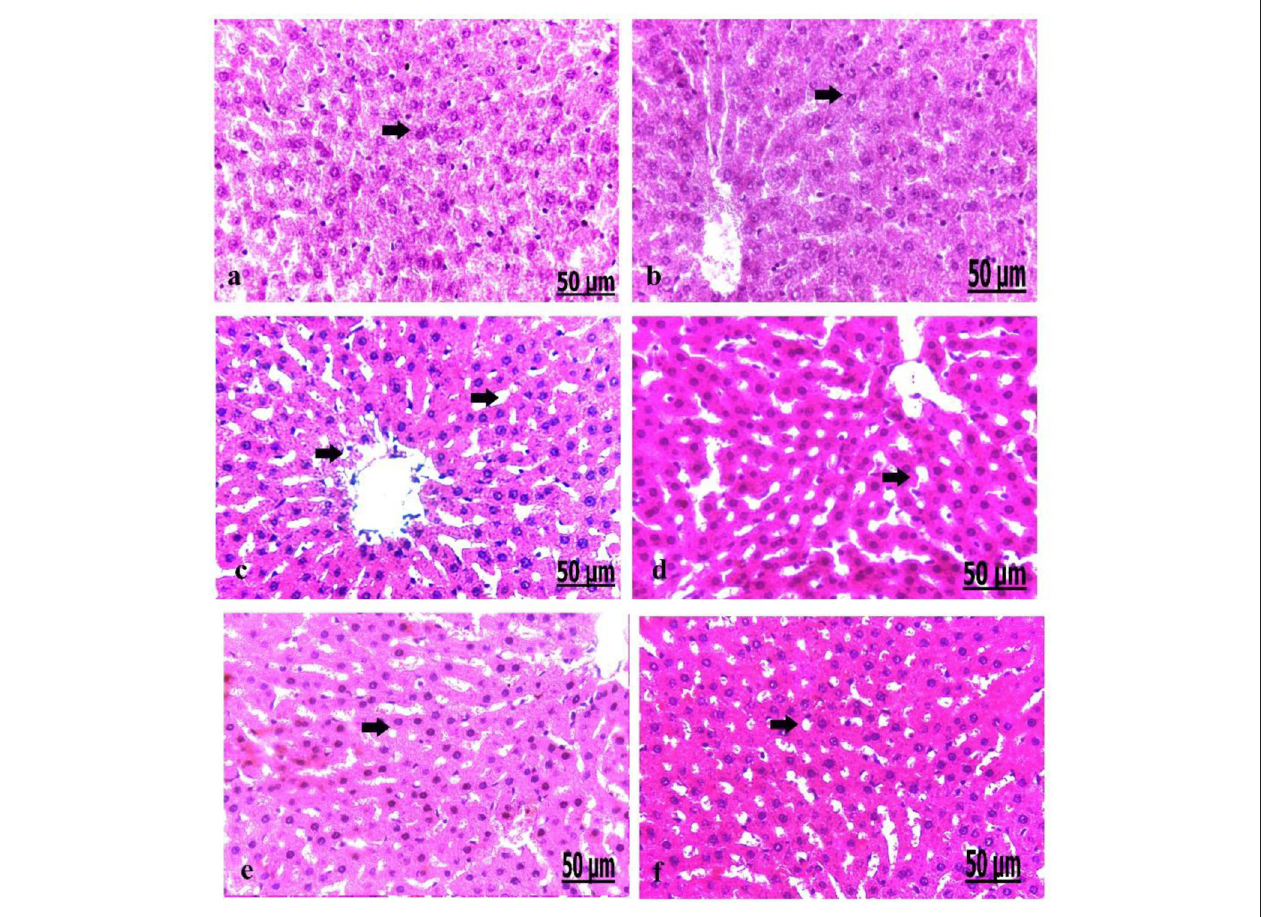
FIGURE 6 | (a–f) Photomicrograph of liver of the control group showed normally arranged hepatocytes with normal vasculature (a) . Photomicrograph of the liver of oxytocin group showed normally arranged hepatocytes (b) . Photomicrograph of the liver of group 3A (prediabetic non-treated) showed necrosis and fatty degeneration of hepatocytes with dilatation of the blood vessels (c) . Photomicrograph of the liver of group 3 B (diabetic non-treated) showed intensive necrosis and fatty degeneration of hepatocytes (d) . Photomicrograph of the liver of group 4A (prediabetic treated) showed a mild degree of fatty degeneration and dilatation of